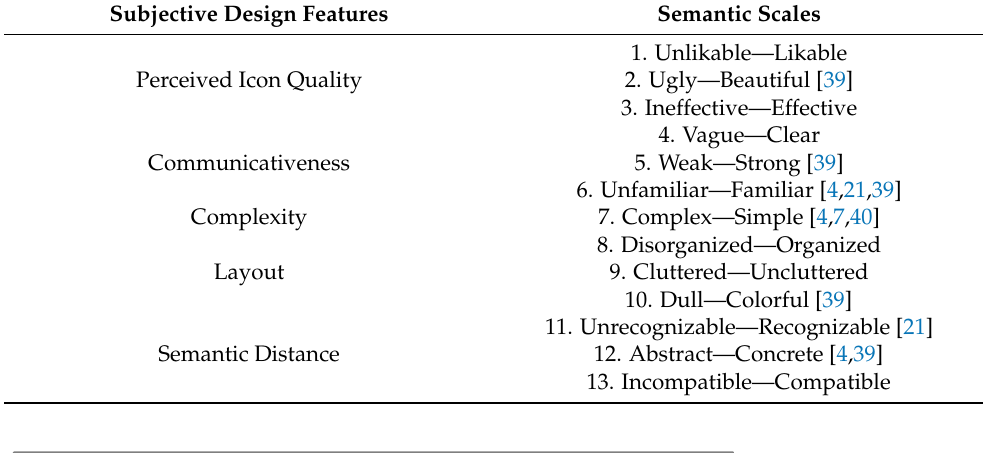
Table 5. Semantic scales and their corresponding subjective design feature.